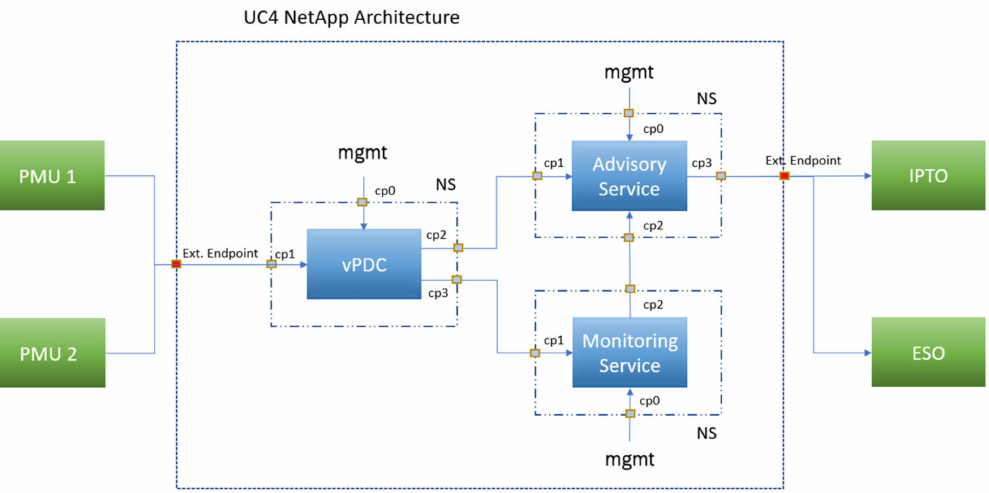
Figure 13. NetApp architecture of